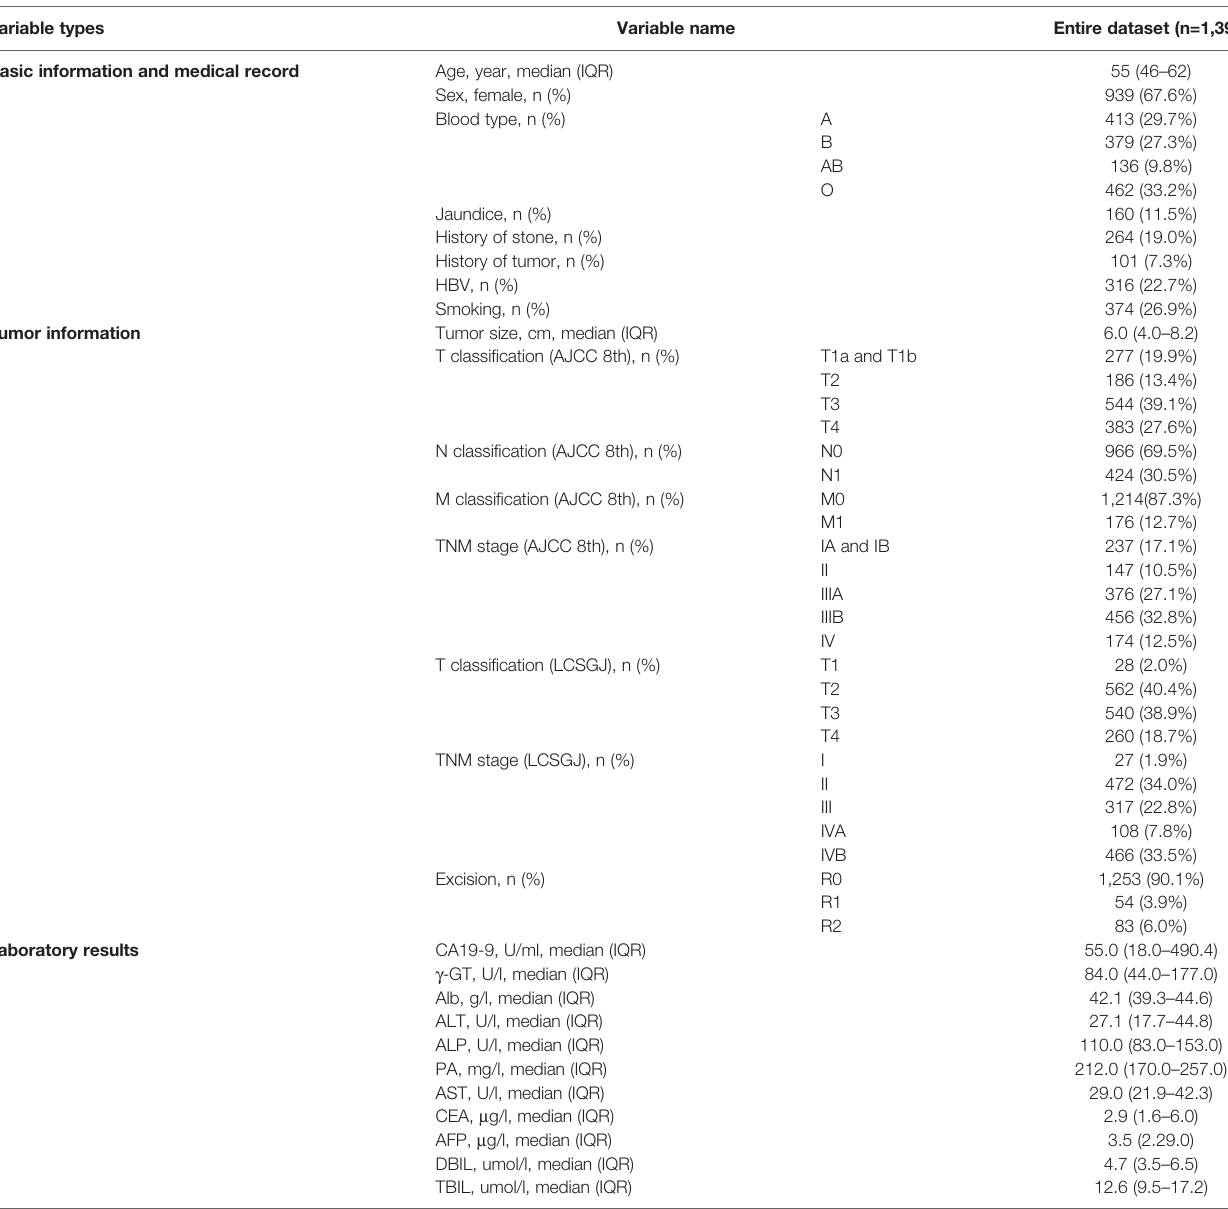
TABLE 1 | Clinicopathologic characteristics of study